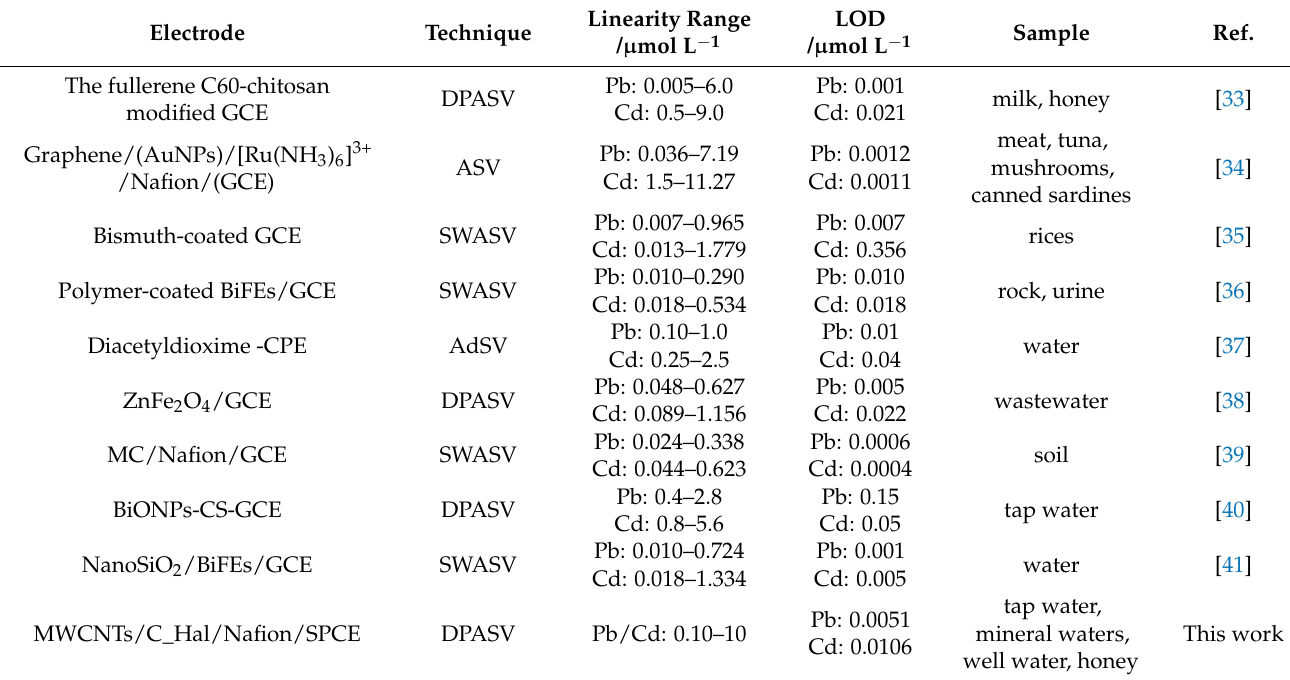
Table 3. Comparison of analytical determination of Cd 2+ and Pb 2+ using reported electrochemi- cal sensors.